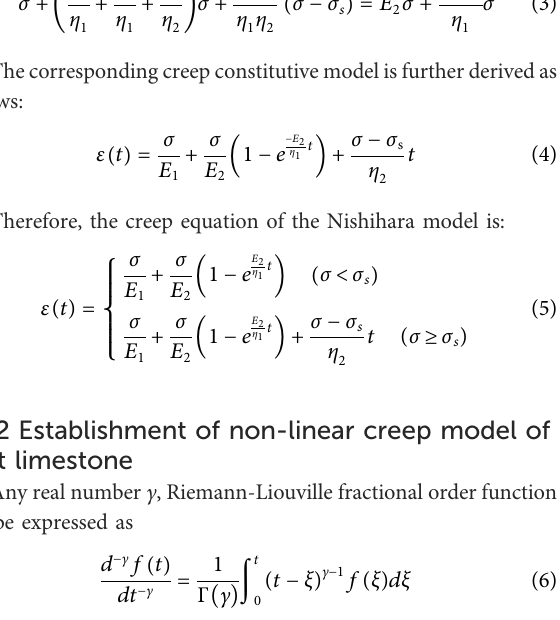
unloading amount is 2 and 4 MPa, the failure form of Flint limestone is shown in Figure 8.